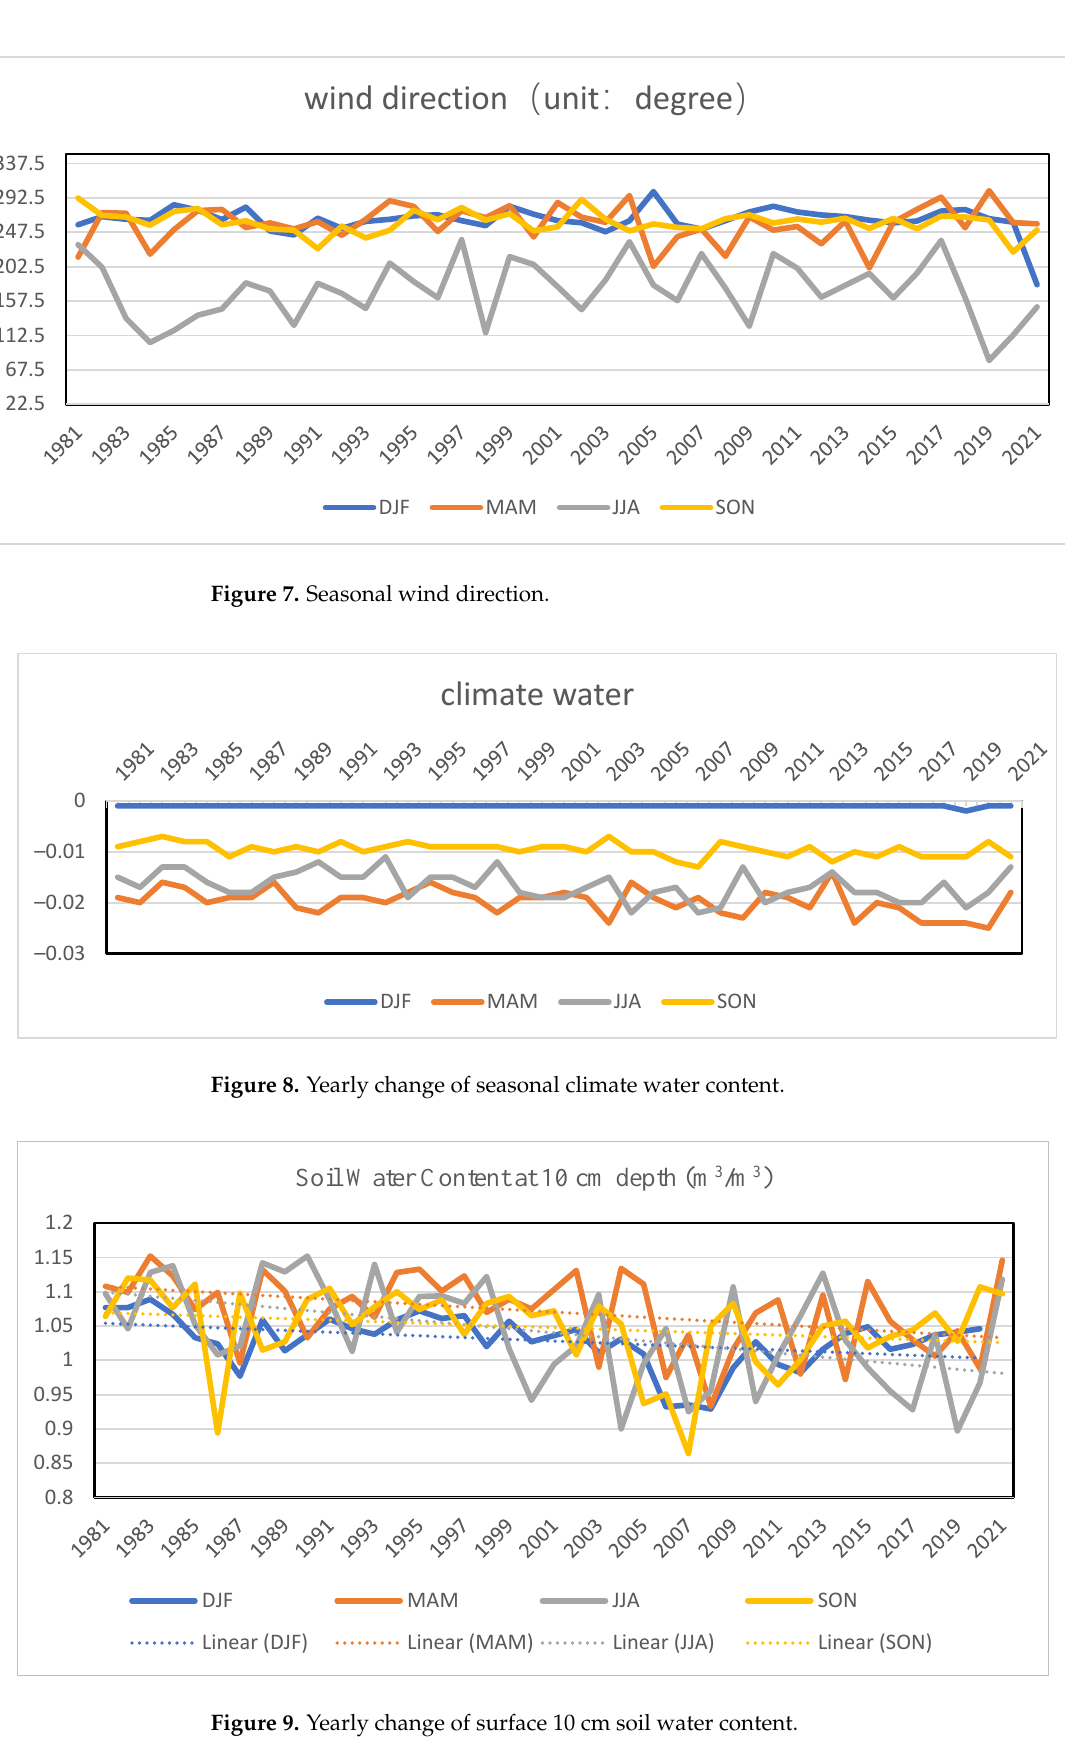
Figure 9. Yearly change of surface 10 cm soil water content. The surface pressure is stronger in SON and DJF than in JJA and MAM (Figure 10). JJA has the lowest surface pressure. The surface pressure difference between MAM and JJA is low. On the contrary, the surface pressure difference between SON and DJF largely differs from between MAM and JJA. In the significant fire years of 2003, 2010, and 2019, there was an increasing surface air pressure in MAM of the following year after a high firefrequency year.